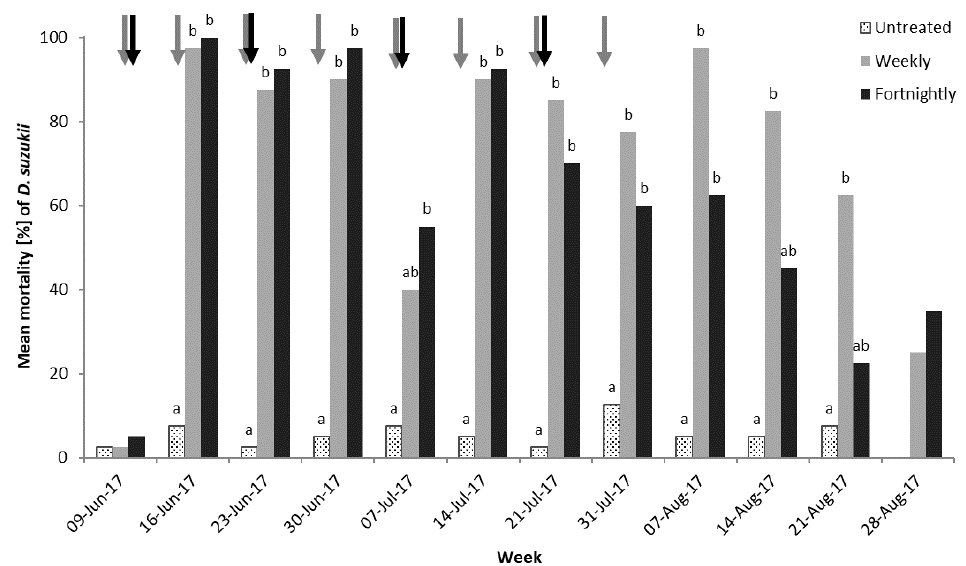
Figure 2. Mean adult mortality (%) of D. suzukii 48 h after exposure to cherry leaves sprayed on a weekly or fortnightly plant protection product program compared to an unsprayed control ( n = 4). The weekly program was; spinosad 9 June, lambda cyhalothrin 16 June, cyantraniliprole 23 June, acetamiprid 30 June, spinosad 7 July, lambda cyhalothrin 14 July, cyantraniliprole 21 July, and pyrethrin 31 July. The fortnightly program was; spinosad 09 June, cyantraniliprole 23 June, spinosad 07 July, and cyantraniliprole 21 July. Data was analyzed using binomial Generalized Linear Models (GLM) with logit link function. Di ff erent letters denote significant di ff erences between spray programs within assessment date (Tukey’s honest significant di ff erence (HSD), α = 0.05). Arrows indicate the weekly (grey) and fortnightly (black) spray timings.